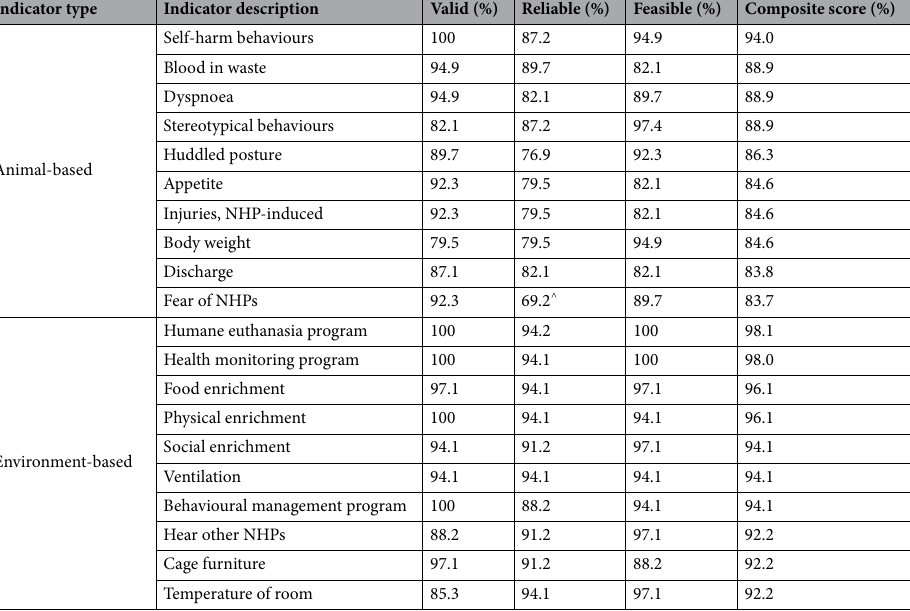
Table 4. Top ten animal- and top ten environment-based indicators by composite percentage agreement score after Round Two. ^ Indicates approaching agreement at a level of 65–69.99% agreement.